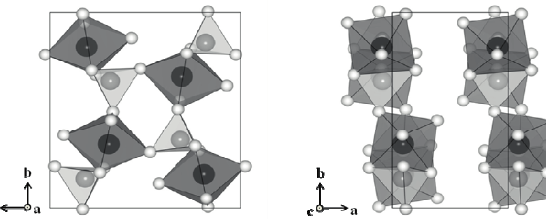
Figure 3. Packing of FeO 6 octahedra and PO 4 tetrahedra in the phosphosiderite unit